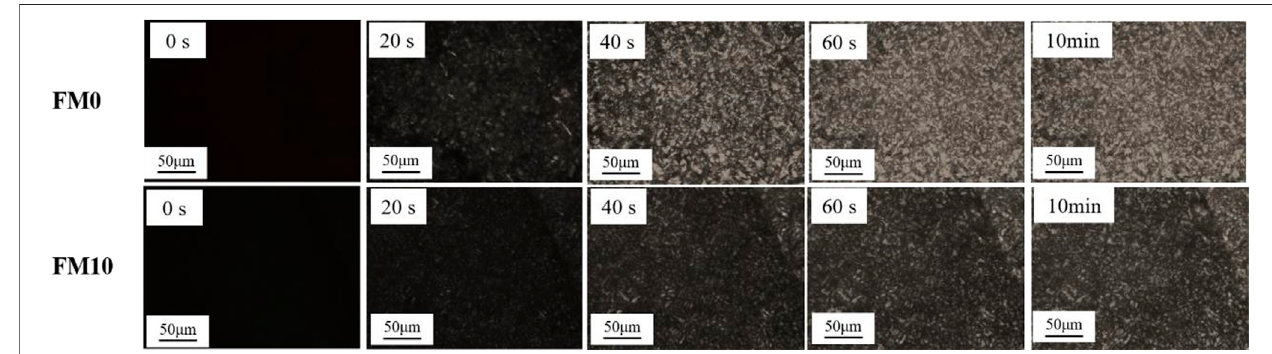
FIGURE 6 | Structural development of FM0 and FM10 during isothermal crystallization captured by POM.